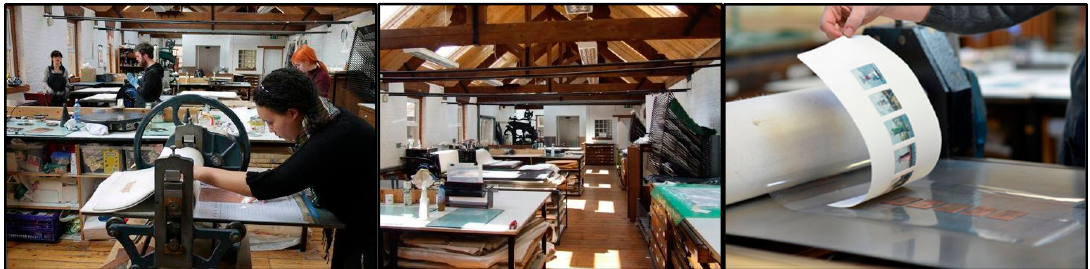
Figure 4. A flavour of the work that takes place in the Graphic Studio Dublin.